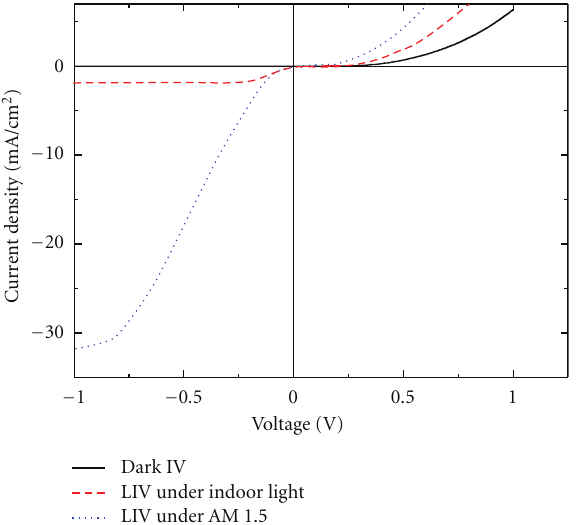
Figure 4: The illuminated current-voltage ( I-V ) characteristics of the device at di ff erent light intensity sources.